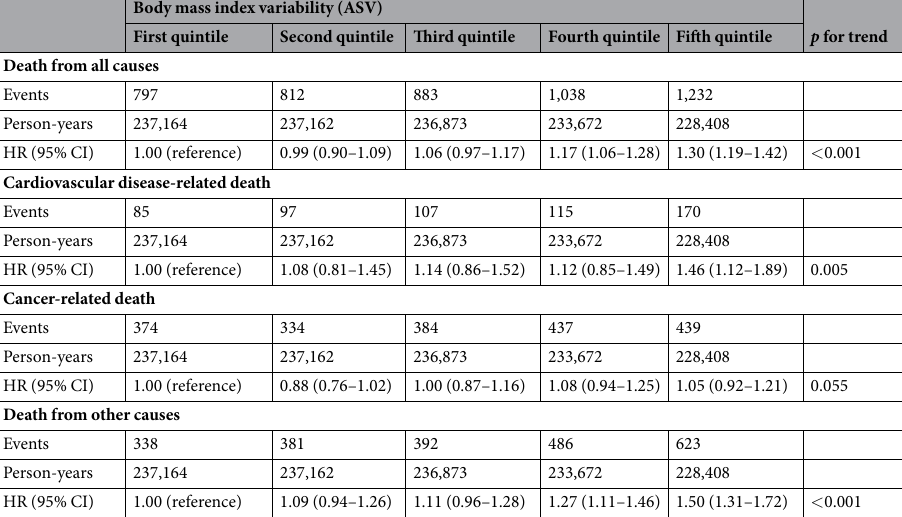
Table 4. Sensitivity analysis of the effect of weight variability on death from all causes after excluding past and current smokers, and individuals with underlying cancer or cardiovascular disease and current smokers. Hazard ratio calculated by Cox proportional hazards regression analysis after adjustments for age, sex, baseline body mass index, change in body mass index, household income, alcohol consumption, physical activity, systolic blood pressure, fasting serum glucose, and total cholesterol. Acronyms: ASV, average successive variability; HR, hazard ratio; CI, confidence